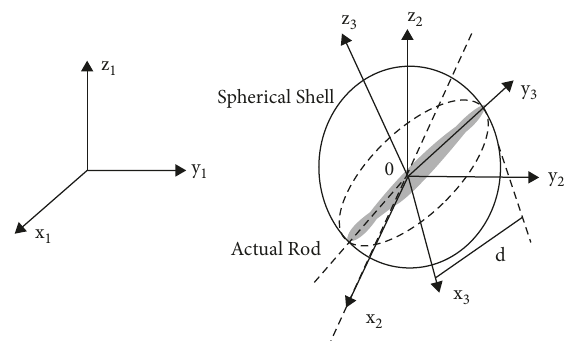
Figure 2: A spherical robot with an actuator.